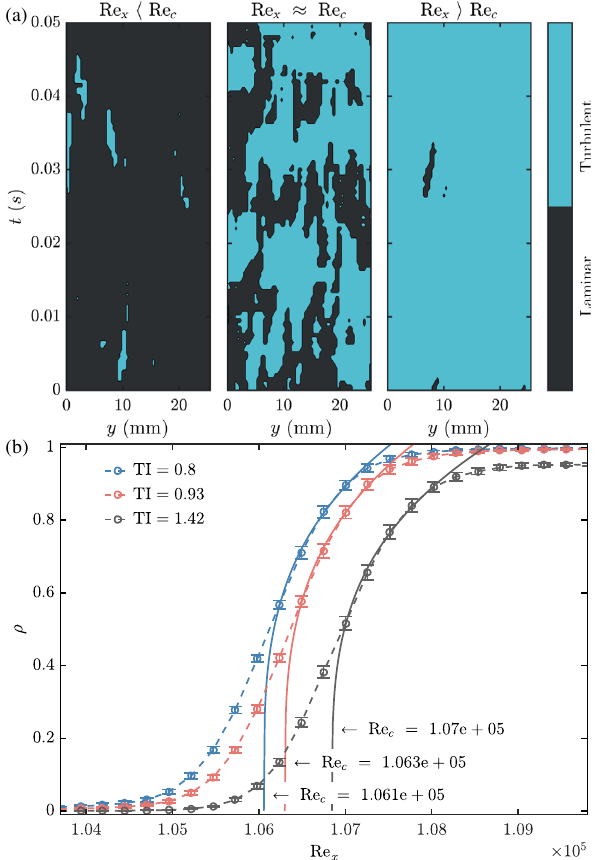
FIG. 4. (a) Three illustrations of cluster distributions in t (time) ¼ 0 . 8 : (Left panel) Reynolds and y (space) derived for TI th number below the critical value Re c , showing a dominance of laminar clusters. (Right panel) Reynolds number above Re c , where turbulent cells dominate. (Middle panel) Reynolds number at the computed Re c for which laminar and turbulent clusters span the entire system. (b) Turbulent fraction ρ (circles), as a function of Re x , where ρ is the fraction of cells with a turbulence intensity larger than a threshold TI . Results are shown for three th different threshold values. The corresponding best fits (solid lines) above the critical point cross the control parameter axis at the critical Reynolds number Re c . Experimental uncertainty of ρ is estimated by the standard error of 10 subsets constituting the total data